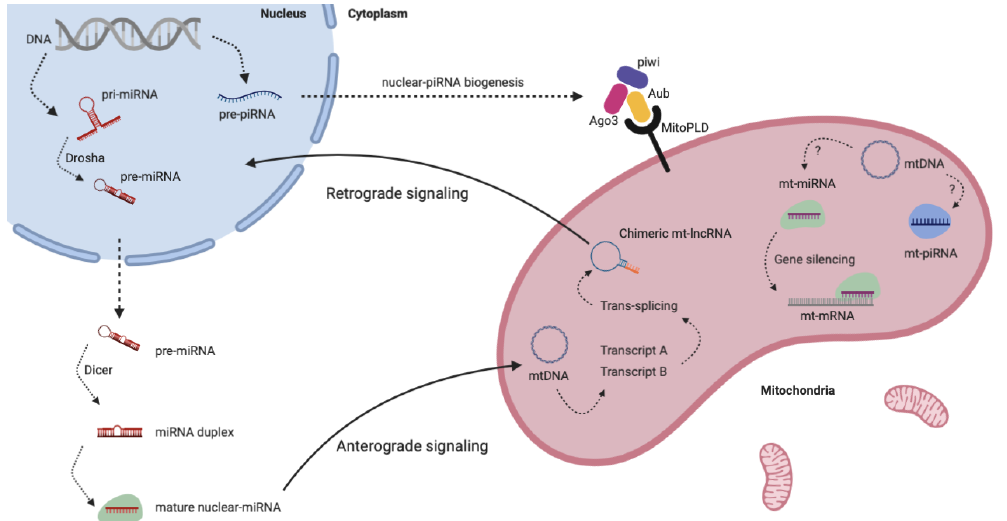
Figure 3. Mitochondria and non-coding RNAs. Scheme showing the complex communication between nucleus and mitochondria through ncRNAs. Nuclear-ncRNAs (miRNAs, for instance) regulate mitochondrial gene expression by anterograde signaling, while mt-ncRNAs (such as lncRNAs) regulate nuclear functions by retrograde signaling. Also, mitochondria produce its own piwi-interacting RNAs (piRNAs) and participate in nuclear-piRNAs’ biogenesis.